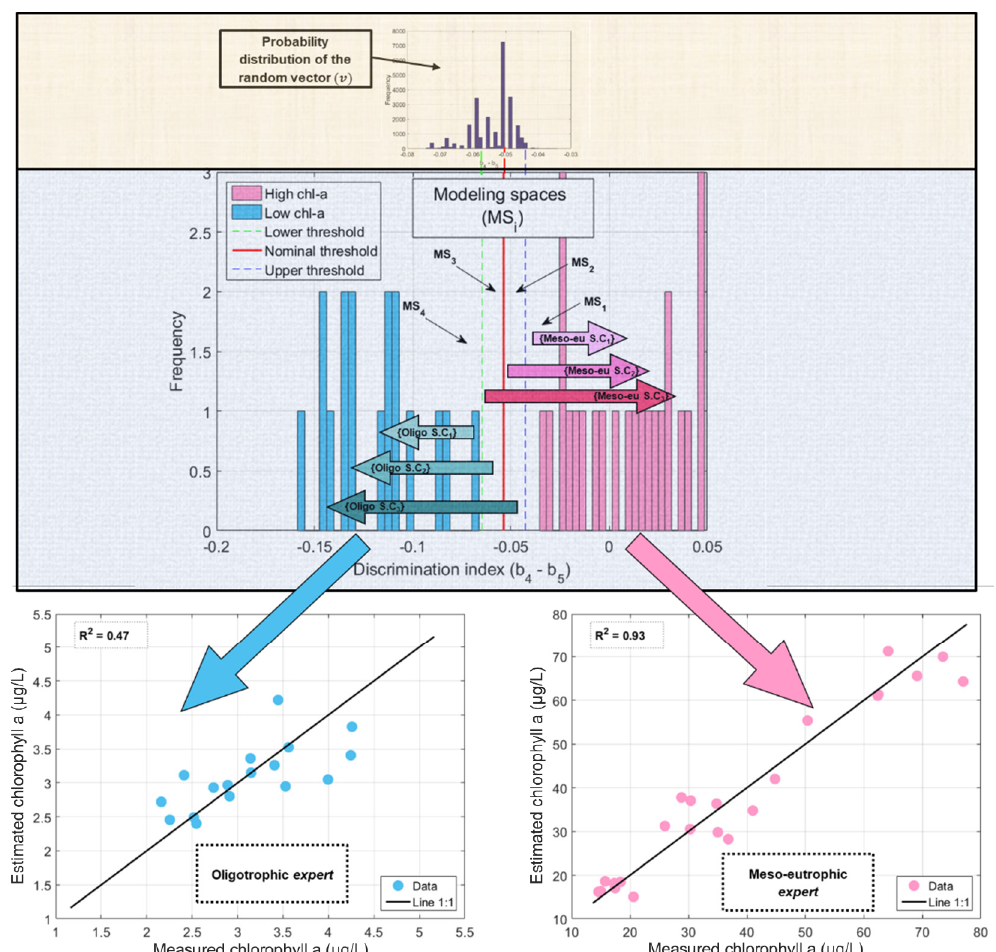
Figure 13. Ensemble-based system calibration using Sentinel-2 simulated bands. (cid:4668)OligoS. C (cid:2869) (cid:4669) , { OligoS.C } are groups of sub-classes, for which the discrimination index is, respectively, inferior to the lower 3